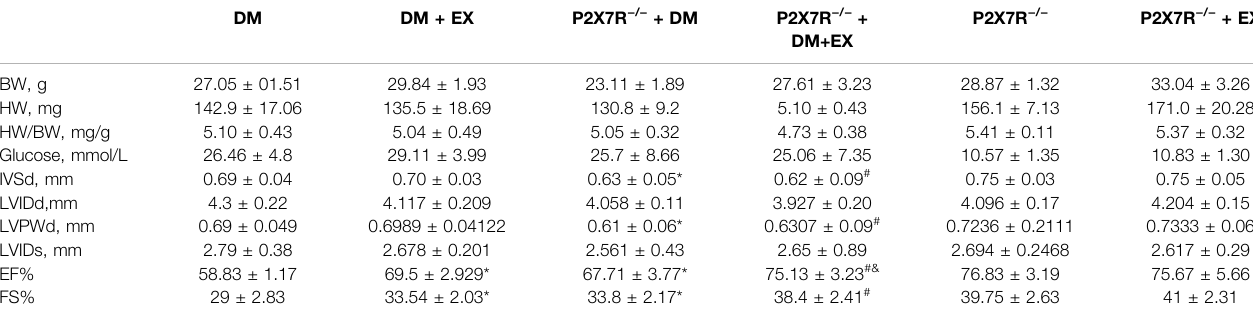
TABLE 3 | Effects of exercise on the biochemistry of diabetic mice (±SD, n =